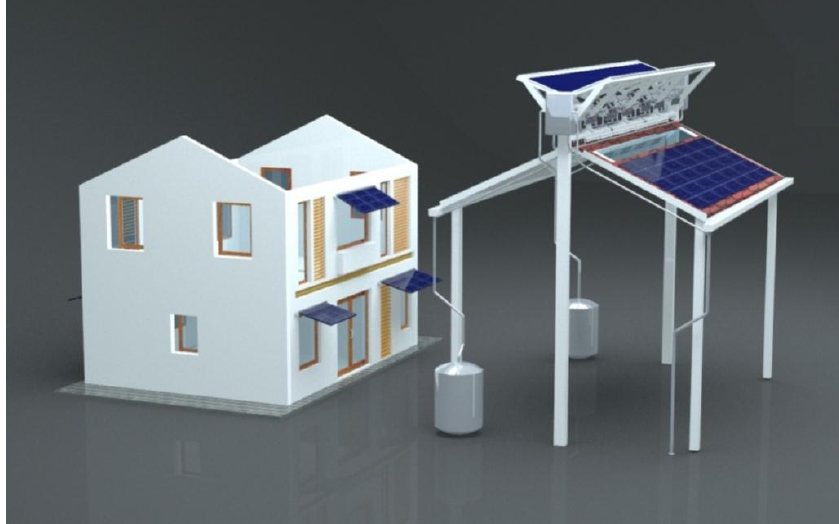
Figure 5. Eco-roof system with the VRGV as a standard system for installation.